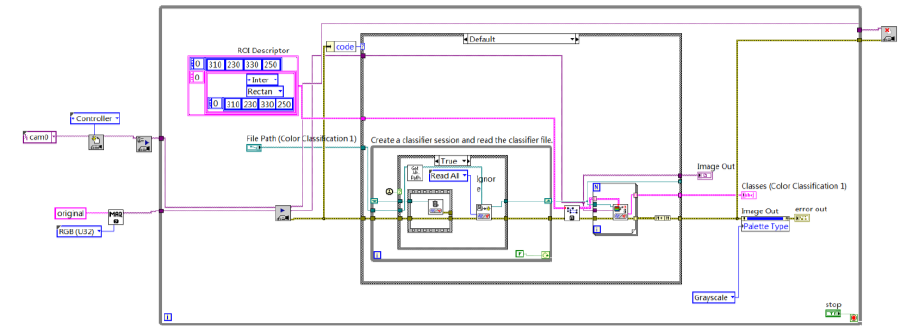
Figure 5. Program block diagram of color recognition.